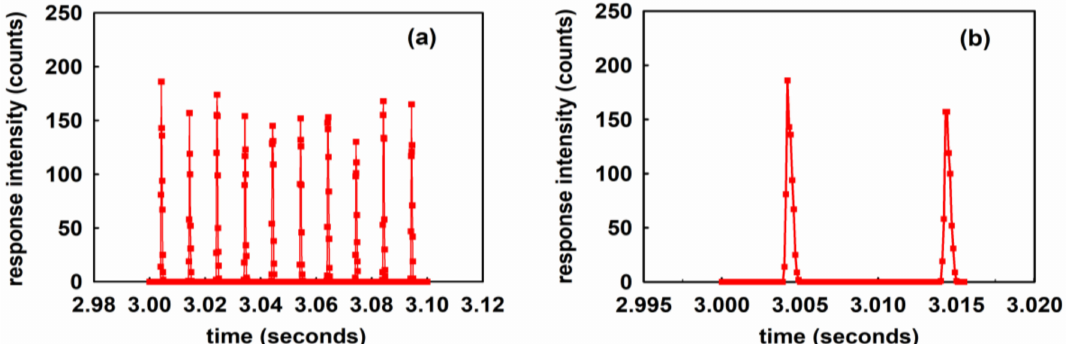
Figure 13. The time-resolved output signals from the UVOFS captured using the MPPC detector with the gate time set to 0.1 ms ( a ) within 0.1 s; ( b ) within 0.015